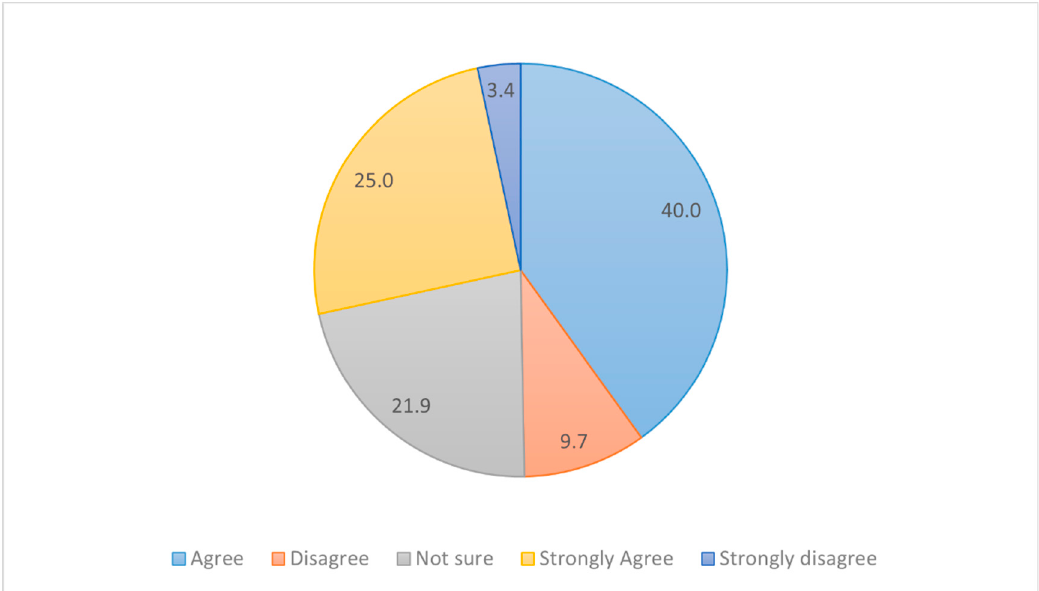
Figure 8. Pie chart reveals the distribution of subjects based on their response to the statement “col- lege teachers/seniors have a great influence on any student’s specialization choice after MBBS”.